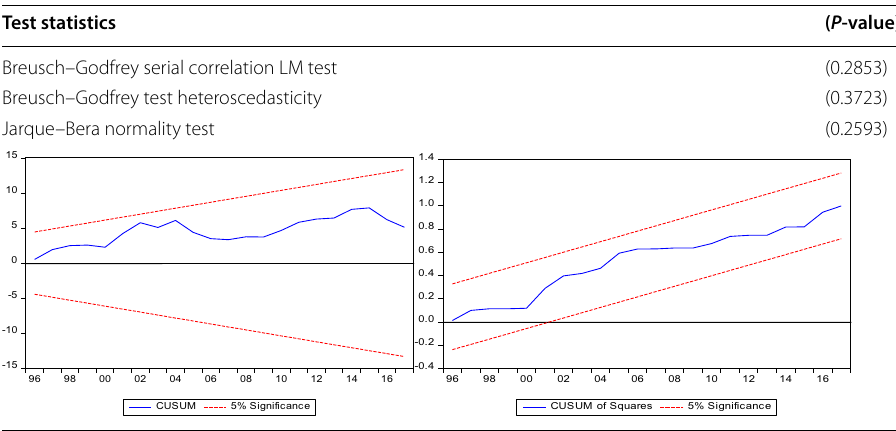
Table 6 Residual diagnostic test